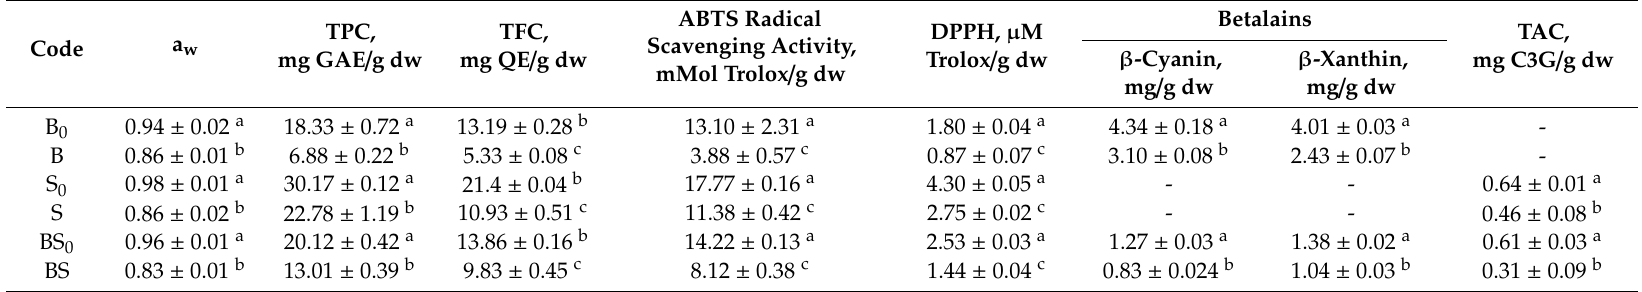
Table 1. Physical and phytochemical results of the tested fresh and marmalade